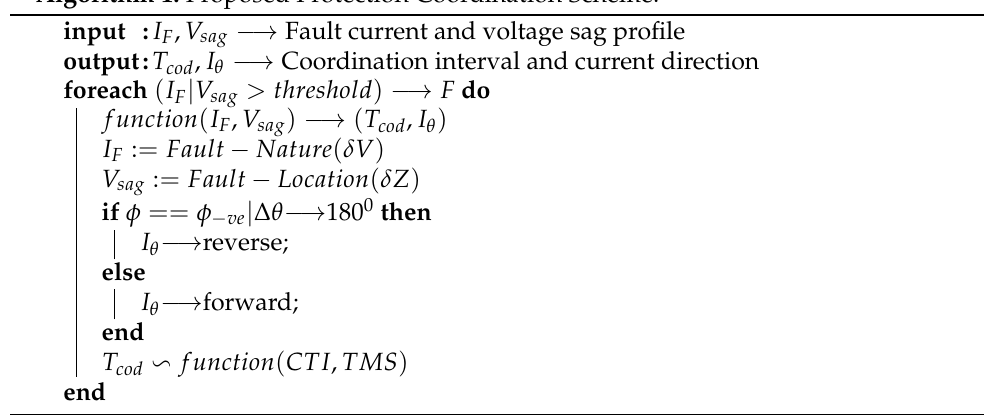
Algorithm 1: Proposed Protection Coordination